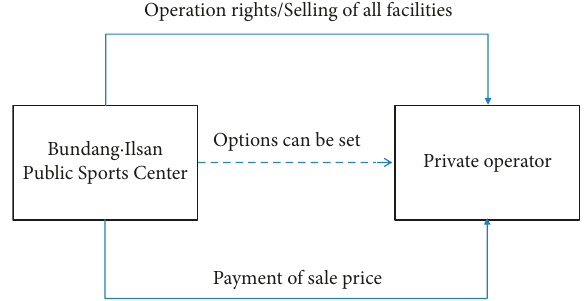
Figure 1: The overall sale structure of the Bundang-Ilsan Public Sports